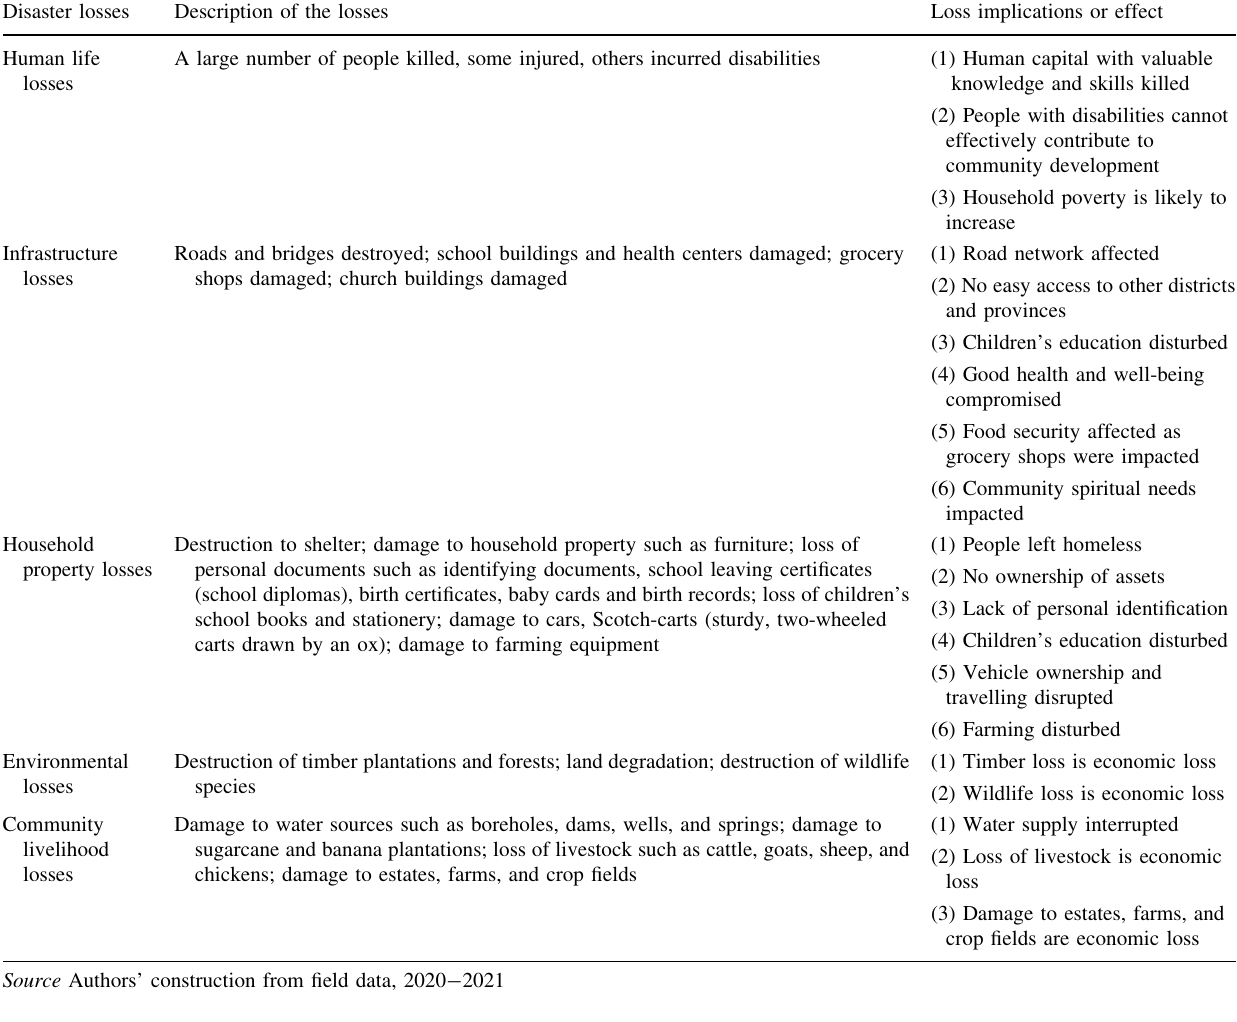
Table 2 Disaster losses impacting communities in Chipinge and Chimanimani Disaster